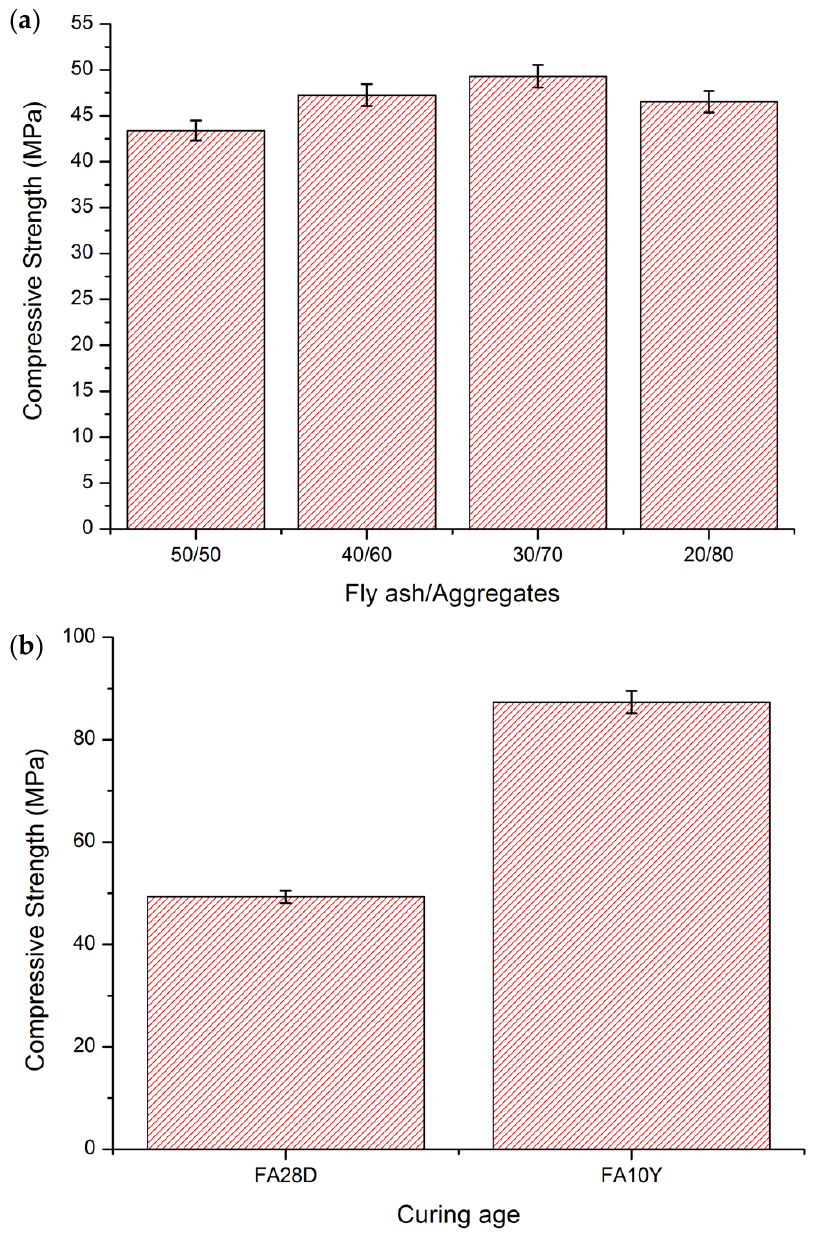
Figure 1. Compressive strength of fly ash geopolymer samples: ( a ) after 28 days curing at various fly ash/aggregates; and ( b ) at 28 days and 10 years of curing age.